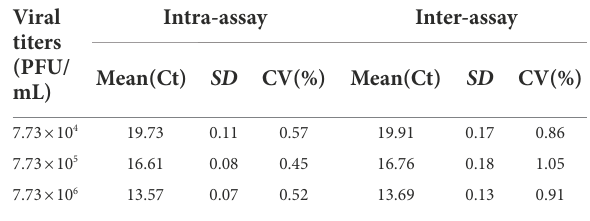
TABLE 1 Intra- and inter-assay reproducibility analysis of SYBR Green I RT-qPCR for GETV.